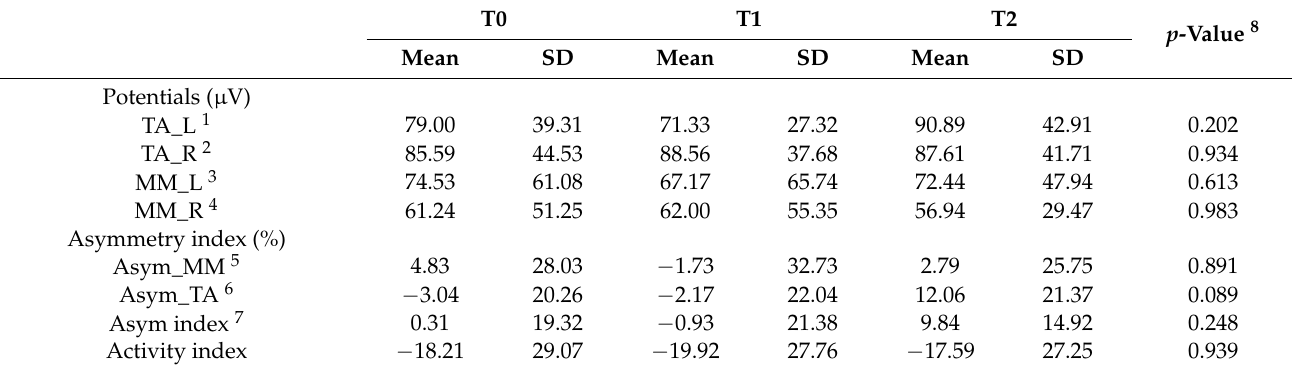
Table 3. Change of EMG potentials in subjects from T0 and